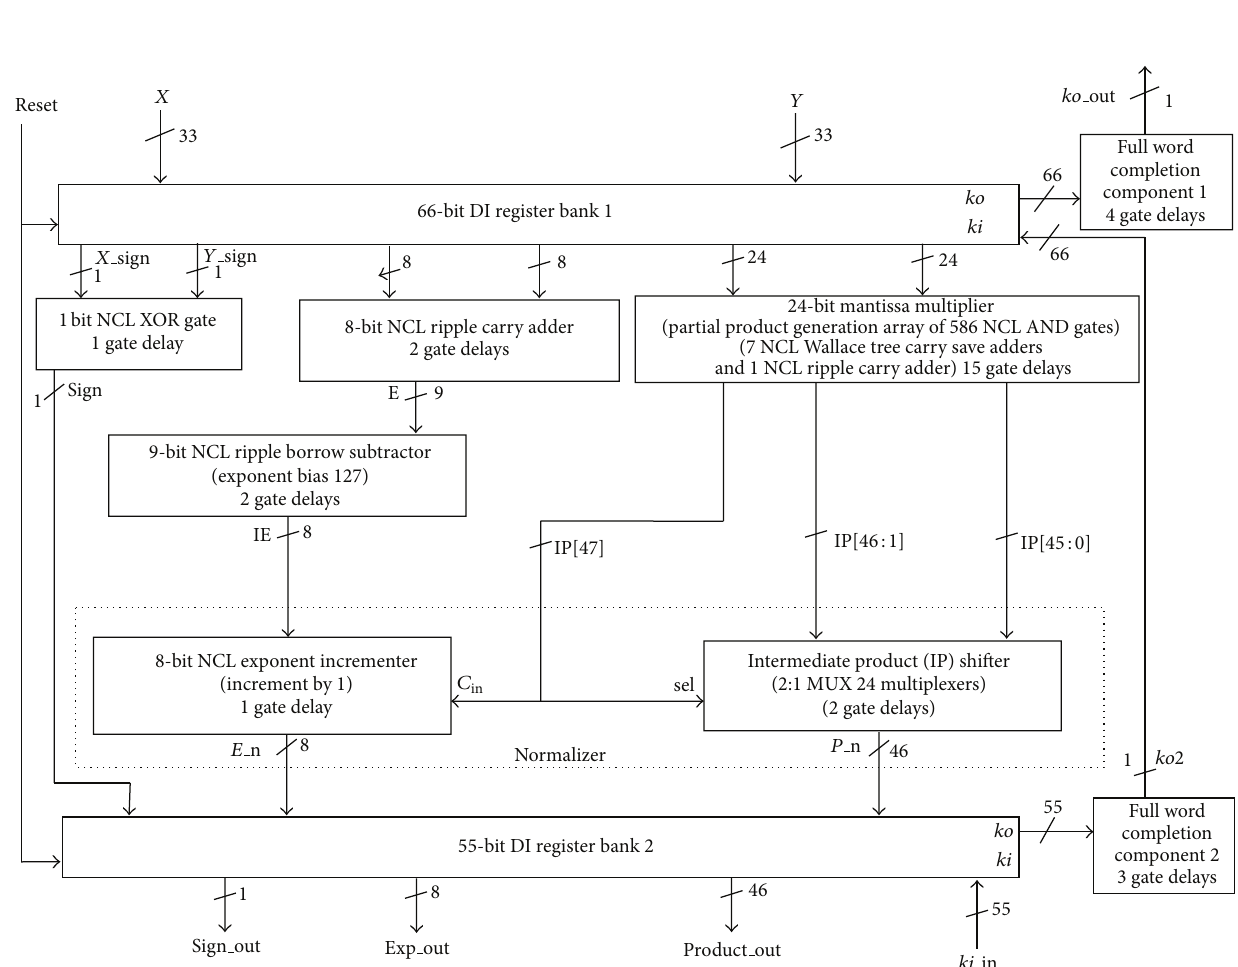
Figure 10: NCL intermediate product shifter.